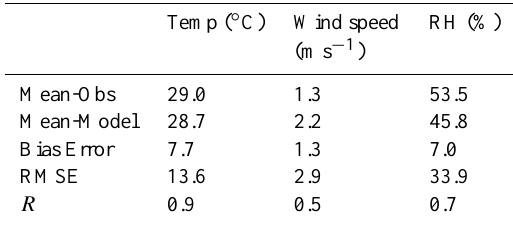
Table 3. Comparison of predicted meteorological parameters with observations at the surface monitoring